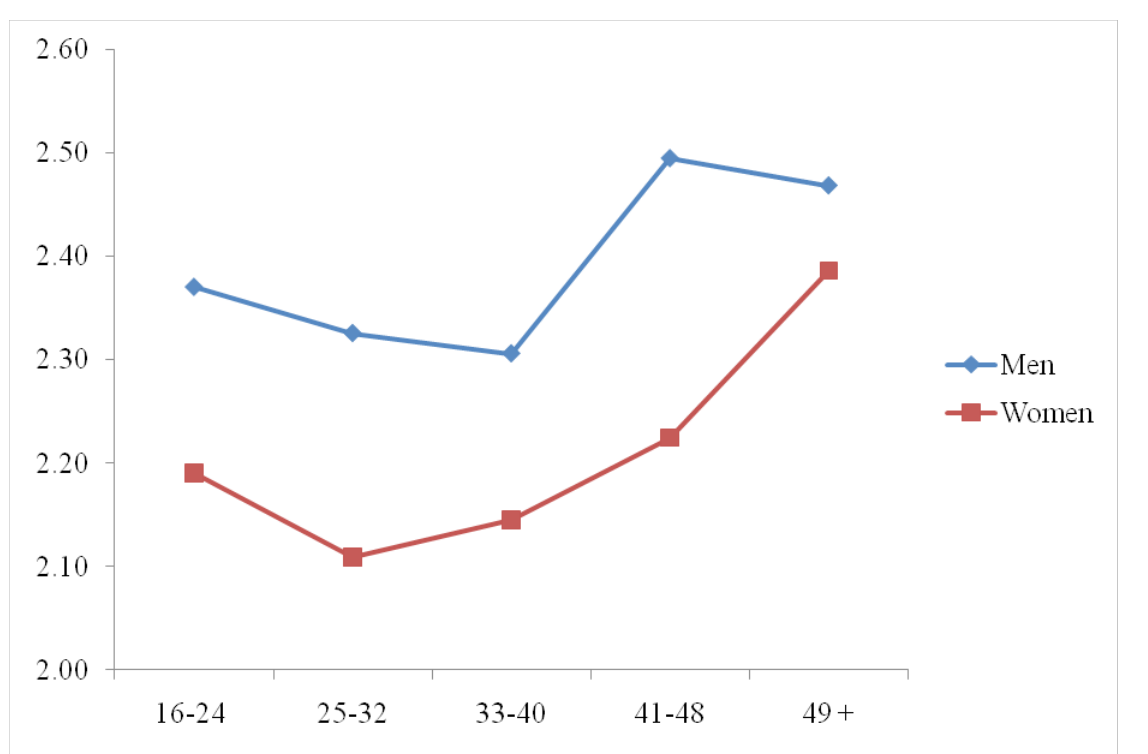
Figure 2. Mean interest in collaborating with peers in a distance course (5-point scale from 1= not at all interested to 5 = very interested